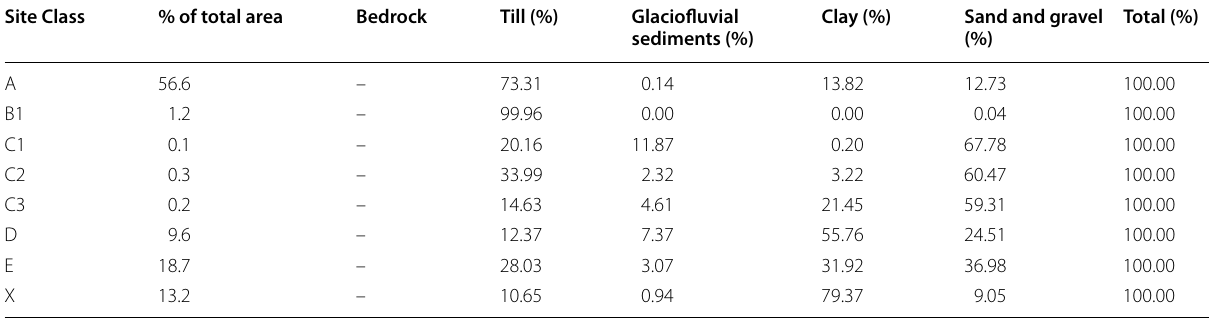
Table 9 Total thickness percentage of geological units contributing to the estimation of site classes based on the hybrid classification